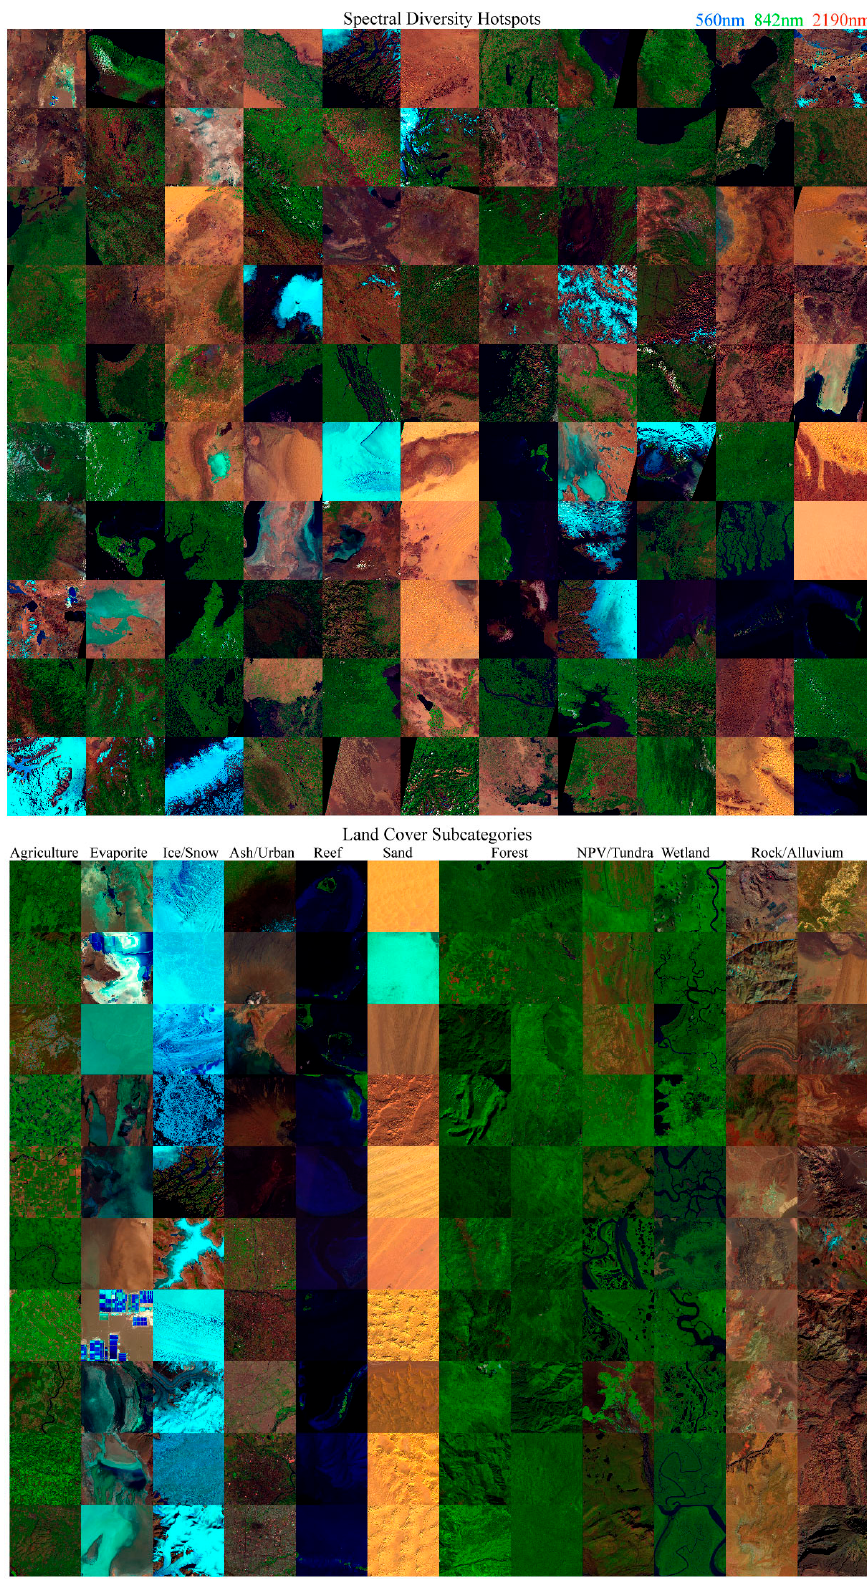
Figure 2. Sentinel 2 composites for 110 spectral diversity hotspot tiles (110 × 110 km) and specific land cover subcategories (10 × 10 km) selected from individual hotspot tiles. Identical 1% linear stretch applied to both